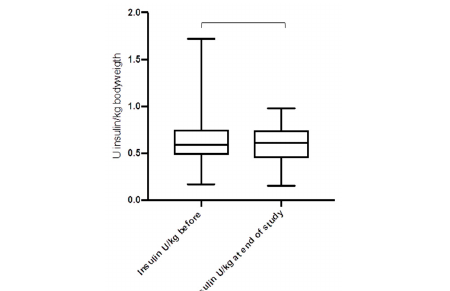
Figure 4. Total daily insulin dose before and after the introduction of CSII and CGM ( n = 41) ( p = 0.62).